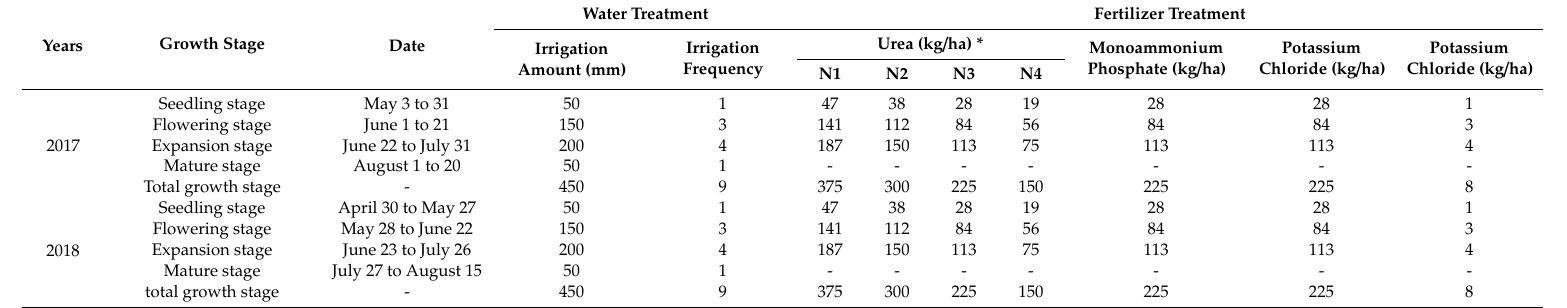
Table 2. Irrigation and fertilizer supply in 2017 and